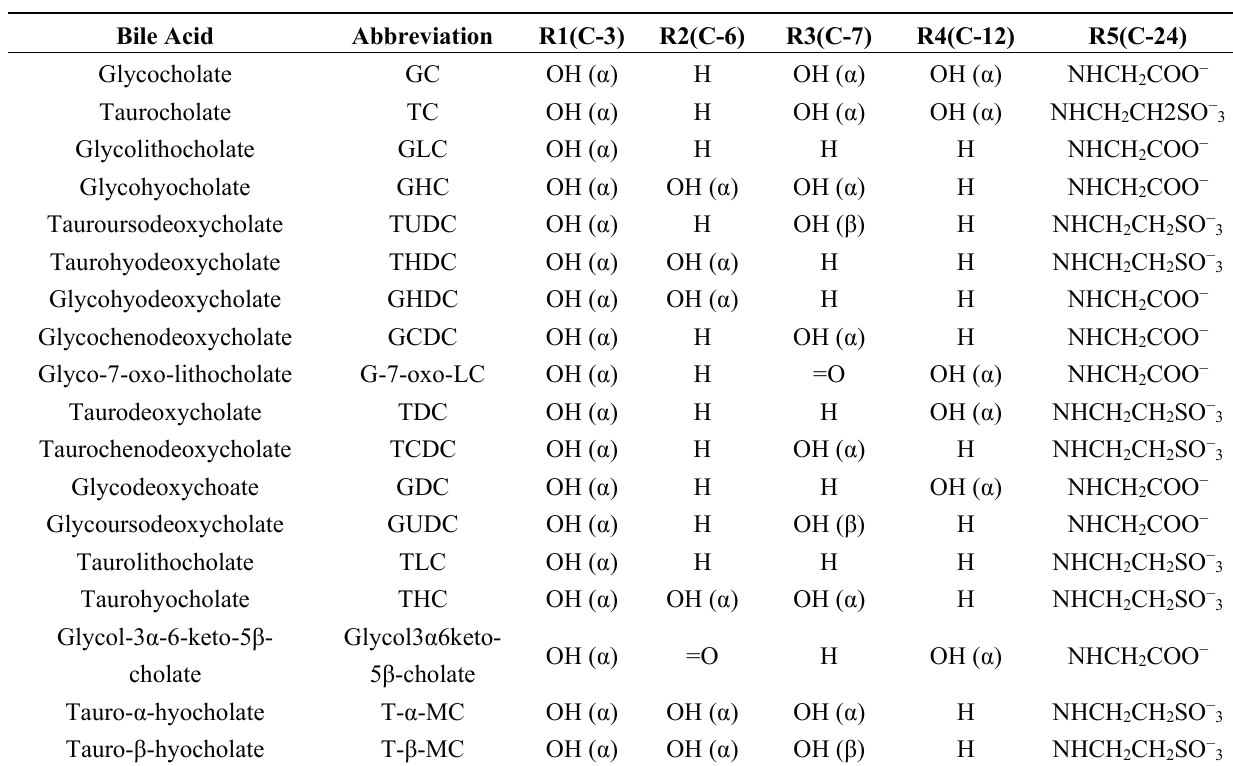
Table 1. Various types of bile acids [9].